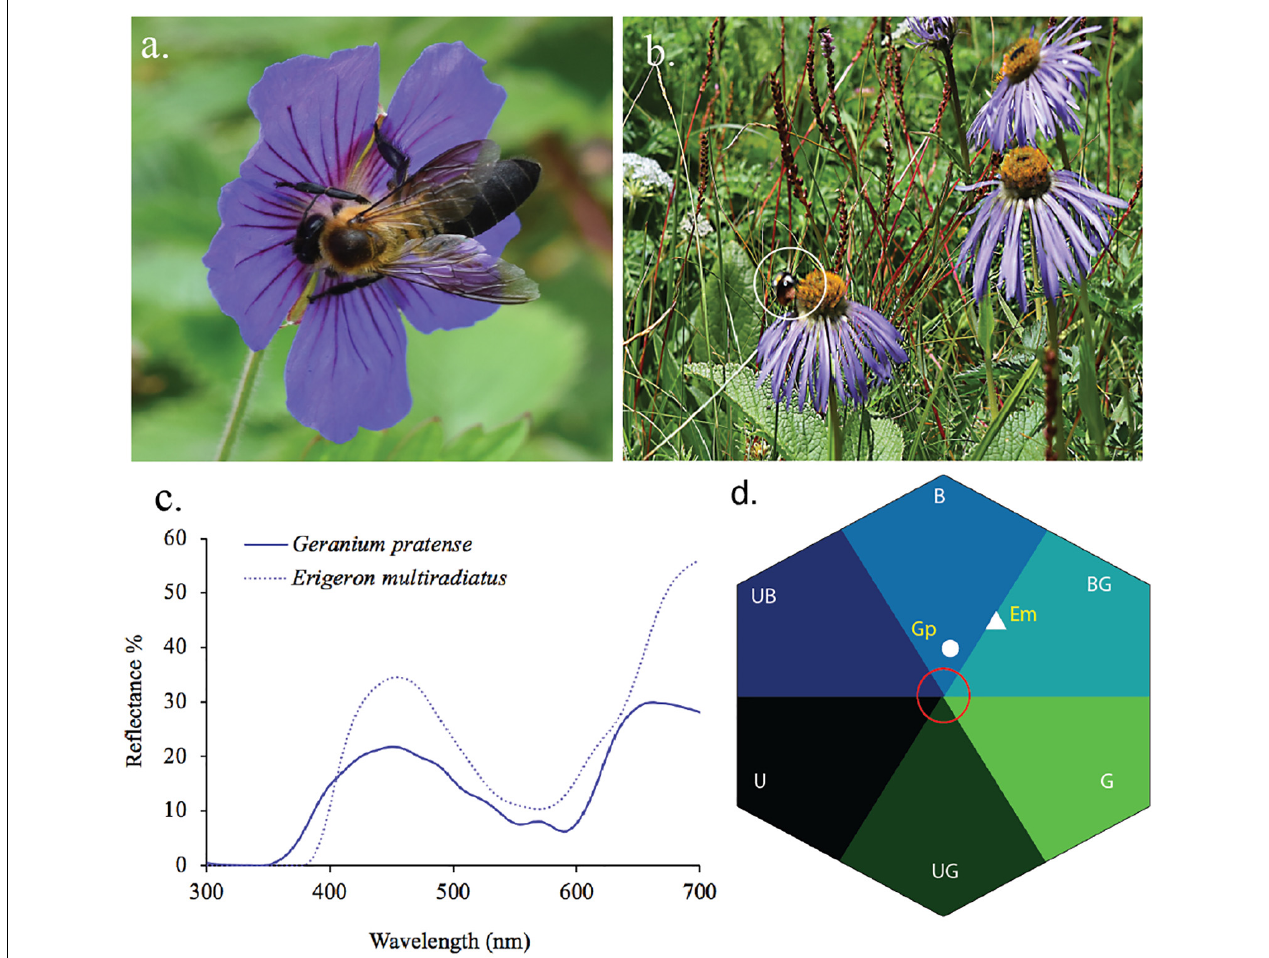
FIGURE 10 | Blue flower and its pollinators from Nepalese Himalaya. (a) Geranium pratense (GP) visited by Himalayan native bees Apis laboriosa , (b) Eriogeron multiradiatus (Em) visited by native bumble bees ( Bombus sp. shown in white circle), (c) reflectance spectra of the two aforementioned species, and (d) reflectance spectra converted into bee hexagon color space. In Nepal Himalaya, native bees are present up to 4200 m a.s.l. (Thapa, 2000) and bumblebees are available/found up to 5000 m a.s.l. including some part of Sikkim Himalaya (Williams et al., 2010; Shrestha et al., 2014; Streinzer et al., 2019).